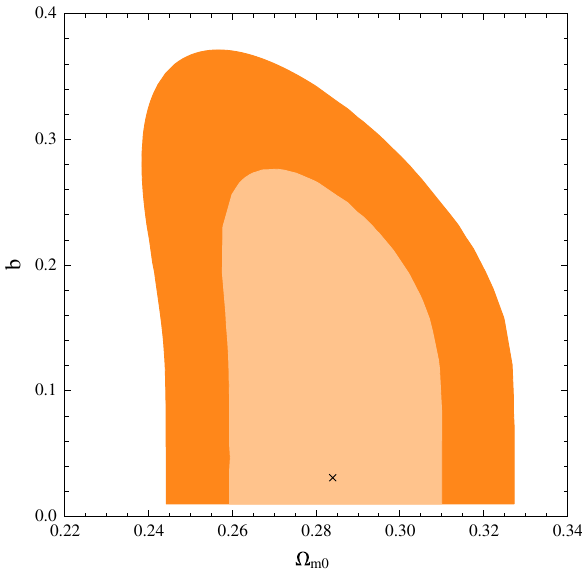
Fig. 4 The evolution of the equation-of-state parameter given in (11), for the f 2 CDM square-root-exponential model of (15), applying a Fig. 3 1 σ and 2 σ confidence regions for the f 2 CDM square-root- reconstruction at 1 σ confidence level via error propagation using the exponential model of (15), obtained from the joint analysis (cid:18)α/α + joint analysis (cid:18)α/α + SNIa + SNIa + BAO. The cross marks the best-fit value Table 3 Summary of the best-fit values of the parameter b ≡ 1 / p of the f 2 CDM square-root-exponential model of (15), for three different / d . o . f . (d.o.f. stands for observational data sets with reduced χ 2 : χ 2 min “degrees of freedom”) b